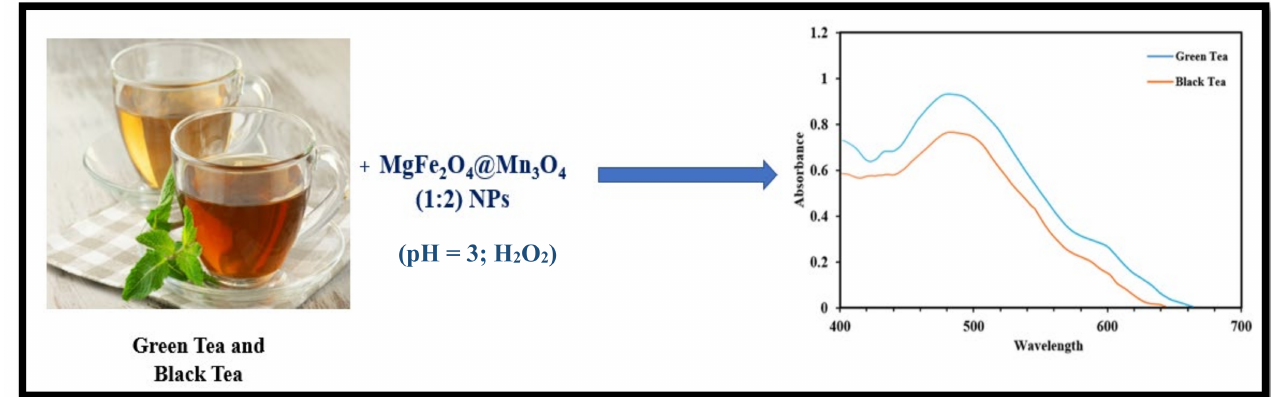
Figure 12. UV-vis spectra of MgFe 2 O 4 @Mn 3 O 4 nanocomposite with tea extracts of green and black tea at pH =